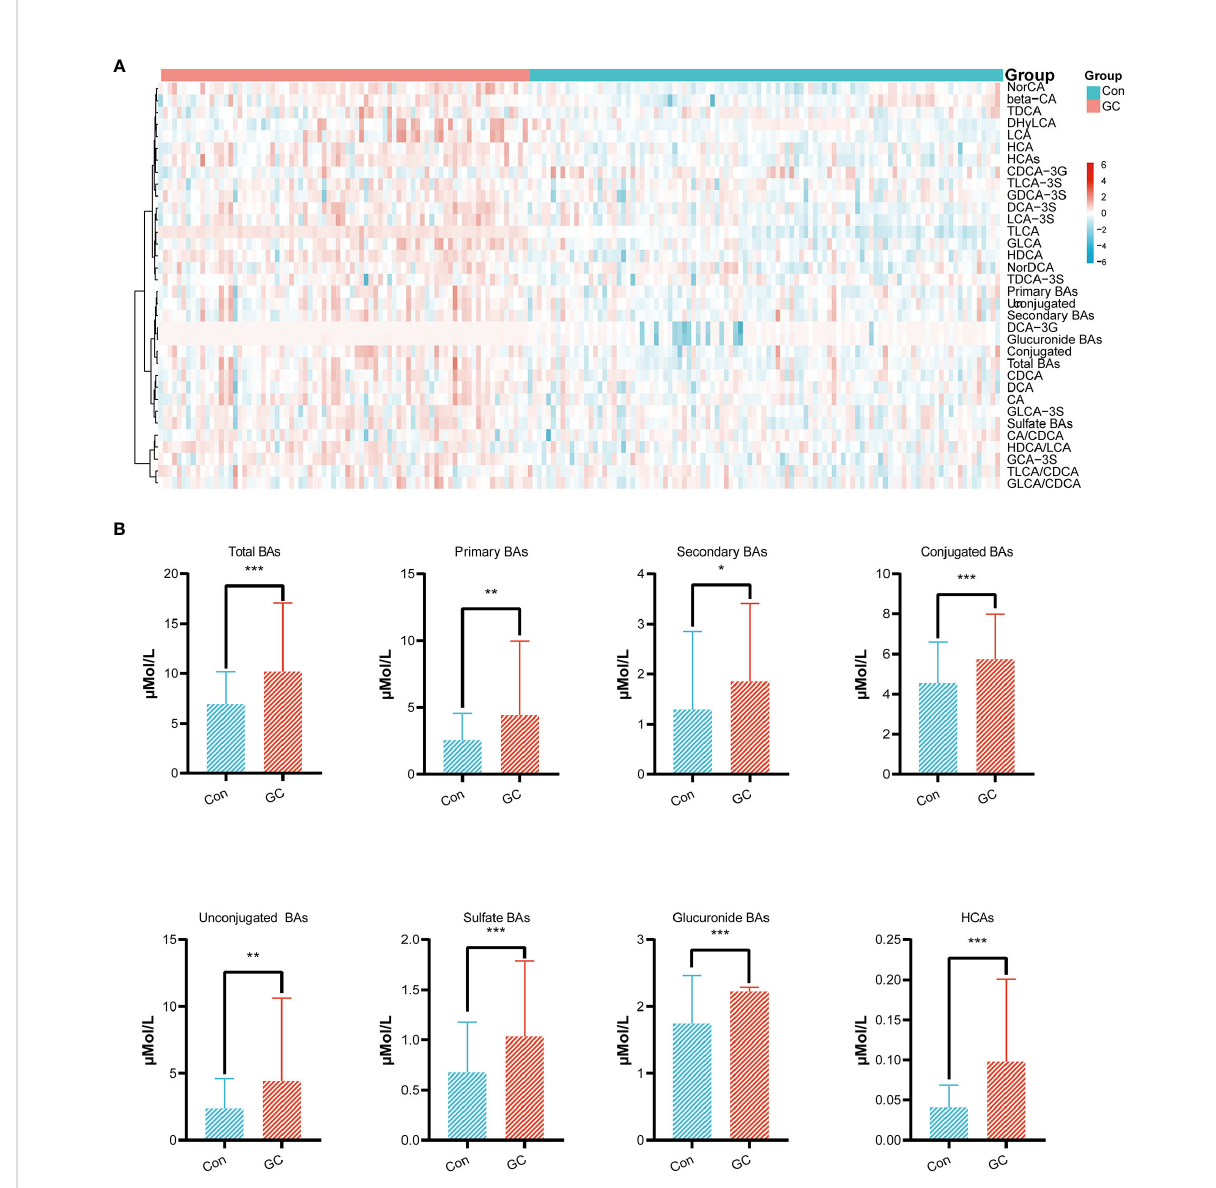
FIGURE 2 Overview of Bile acids. Differential expression of BAs, BA ratios and total concentration of BA sub-classes between the GC and Con groups were plotted as heat-map (A) . In this plot, red represents a higher concentration, while blue represents a lower concentration. Concentrations of eight kinds of BA sub-classes in the GC and Con group. For all fi gures, FDR-adjusted Q-value: *Q<0.05; **Q<0.01; ***Q<0.001 (B)